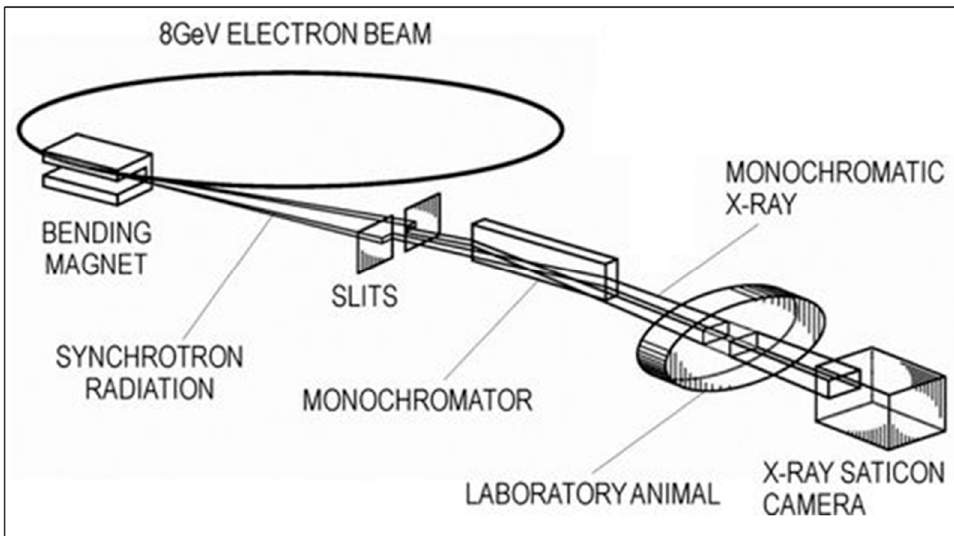
Figure 1. A simplified layout of a synchrotron to produce monochromatic X-ray radiation. Reproduced with modification from [4].